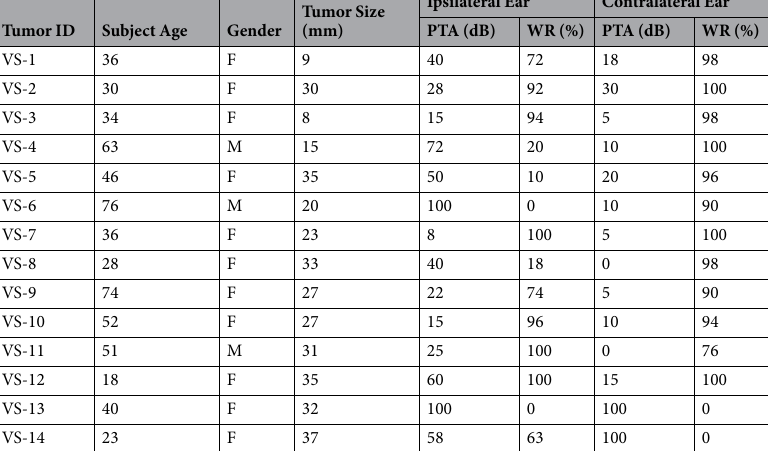
and functions as a key mediator for tissue extravasation and tumor penetration 26 . We hypothesized that both VS-derived primary cell cultures and archived tumor specimens from patients with unilateral, sporadic VS over- expressed sufficient amounts of α v integrin and NRP-1. An established human epithelial ovarian cancer cell line (OVCAR-8) known to express both receptors was used as a positive control 22 . In an NF2-derived human schwan-